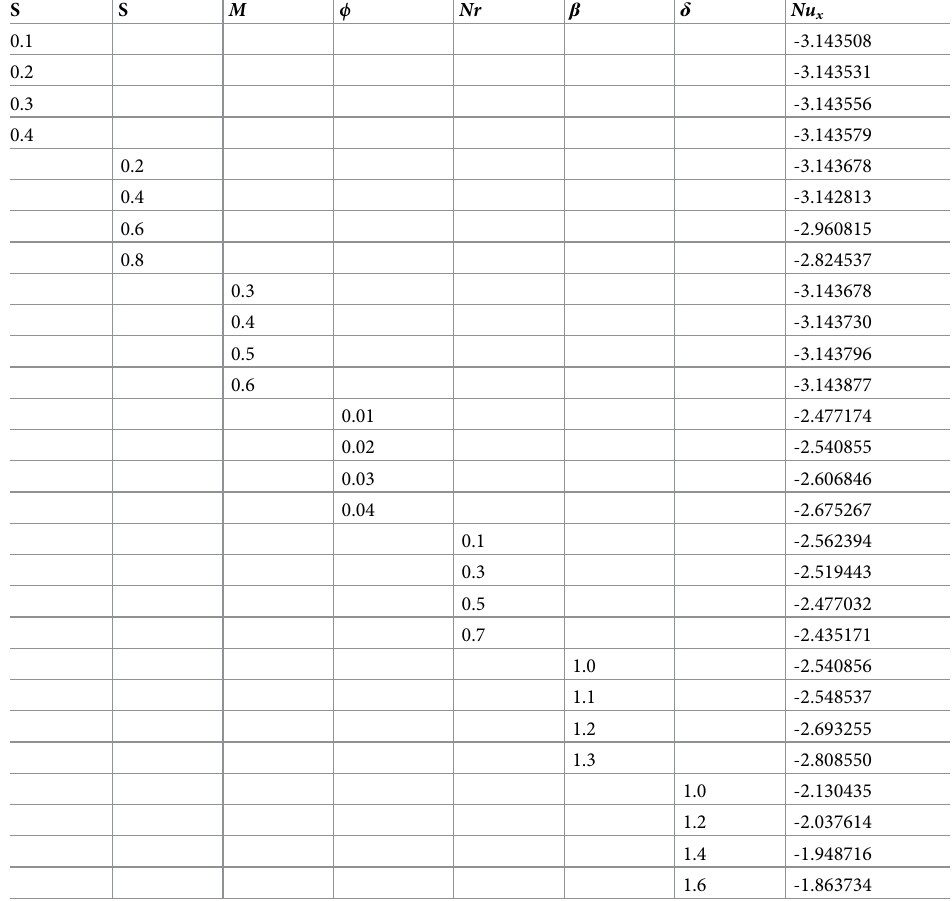
Table 4. Nusselt number Nu x variation against m , n , M , ϕ , Nr , β and δ